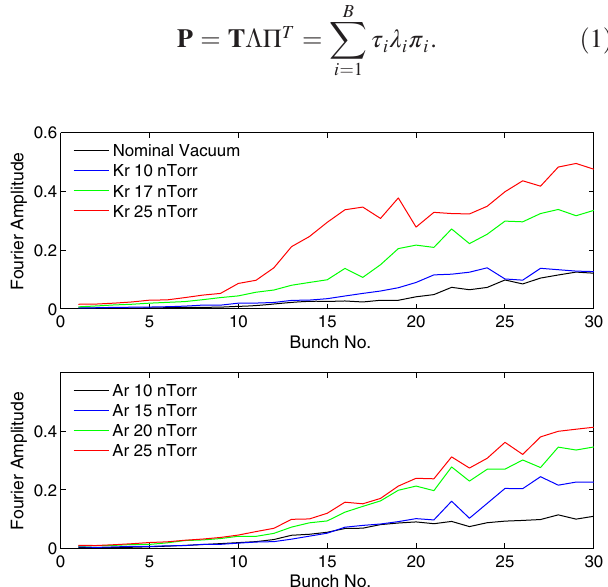
FIG. 2. Amplitude at vertical tune, obtained from FFT of vertical bunch motion (in mm), as a function of bunch number at different